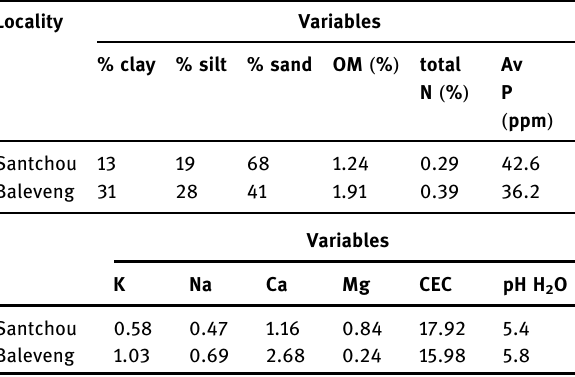
Table 1: Physico - chemical characteristics of soils samples in the studied localities Locality